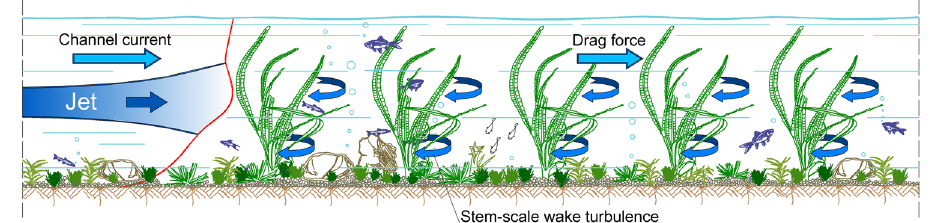
Figure 1. Example of patterns of a jet flow in a channel current with aquatic plants and stem scale wake